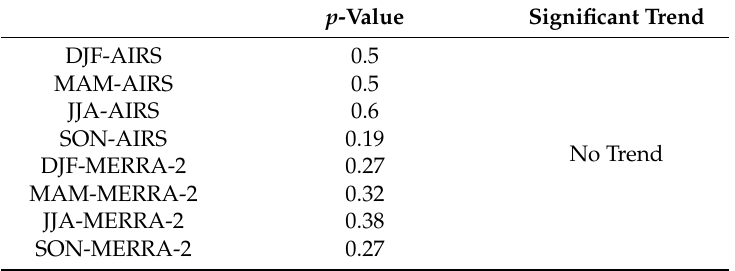
Table 6. Summary of the results of Mann-Kendall test for the eight seasonal monthly average TOCs over Egypt